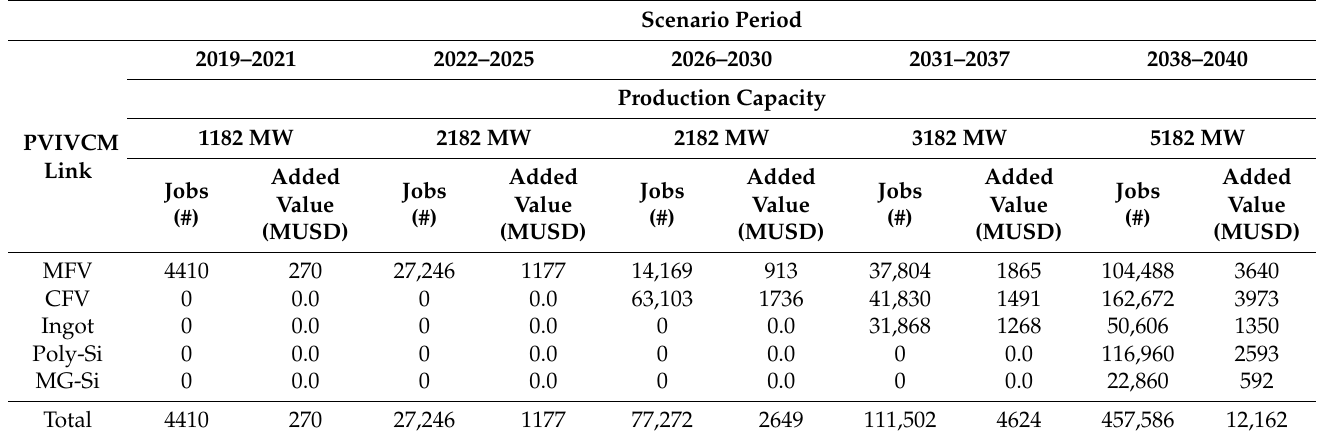
Table 15. Job creation and added value evolution in terms of the integration of VCPVIM links in the Alternative Scenario,